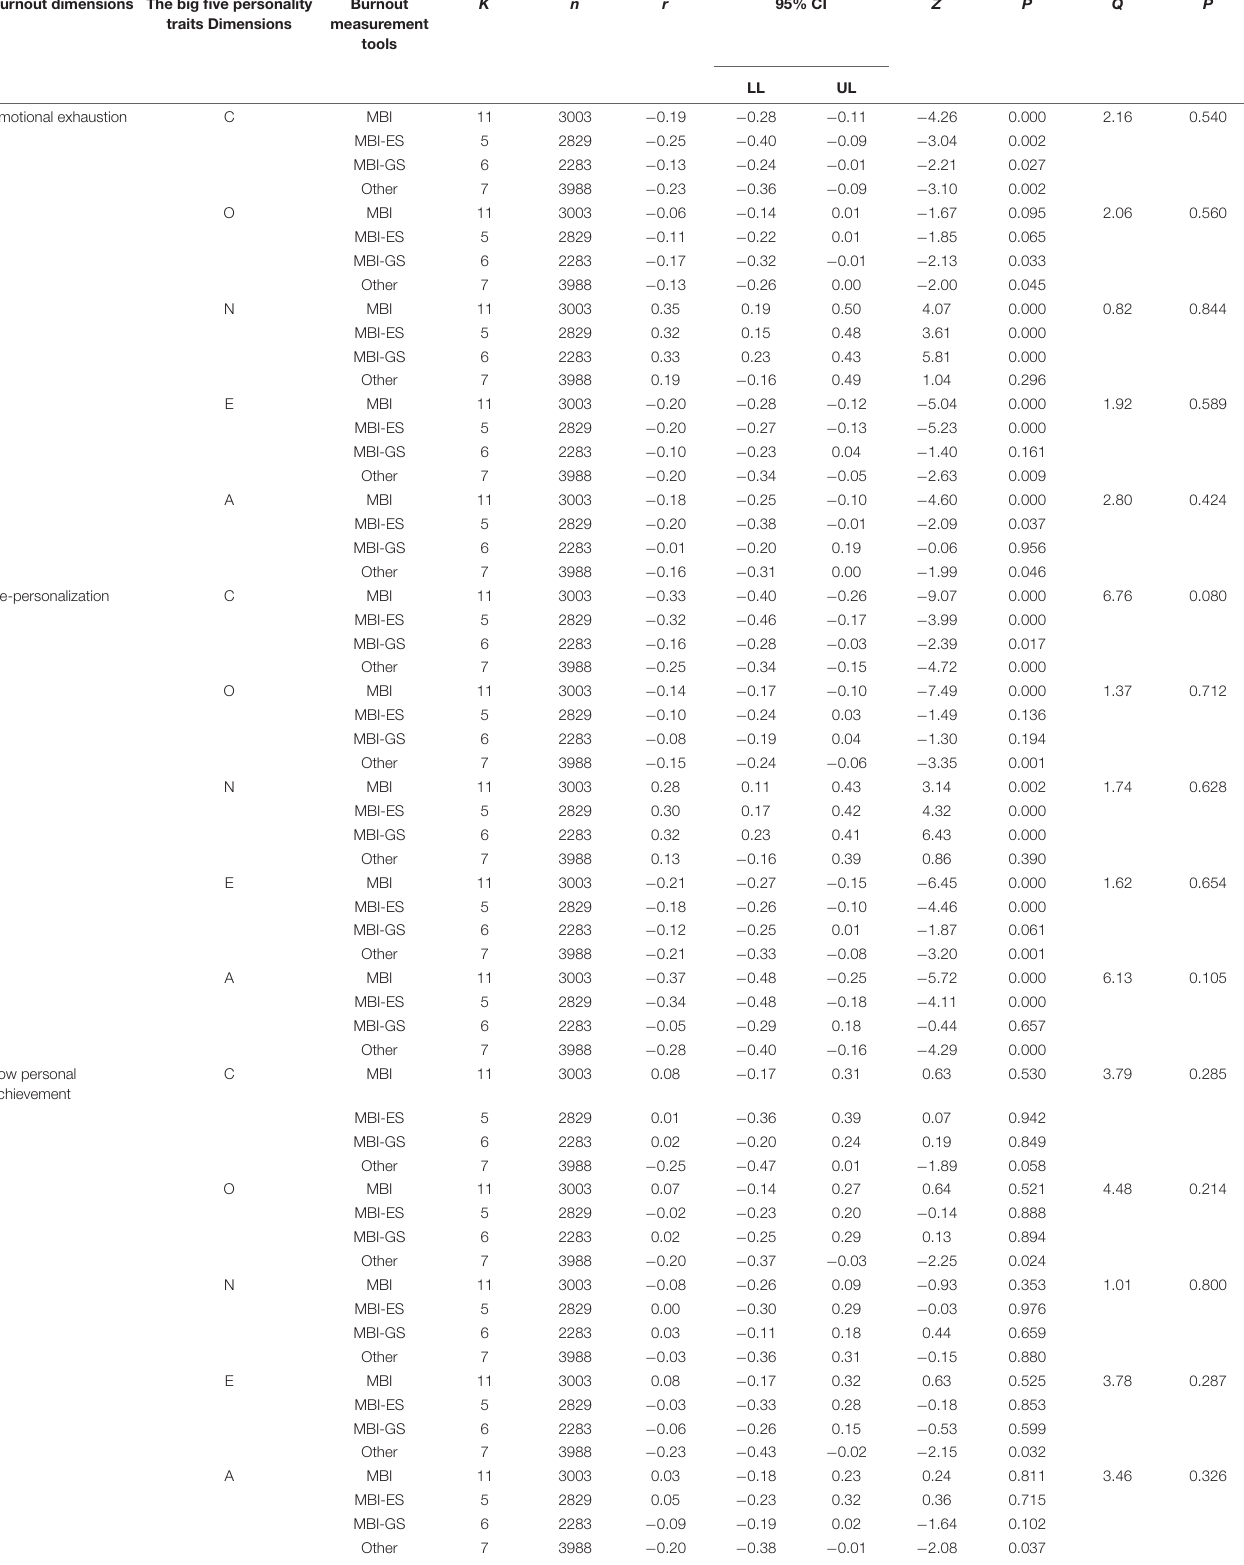
TABLE 8 | Moderating effects of job burnout measurement tools on the relationship between big five personality traits and job burnout. Burnout dimensions The big five personality Burnout traits Dimensions